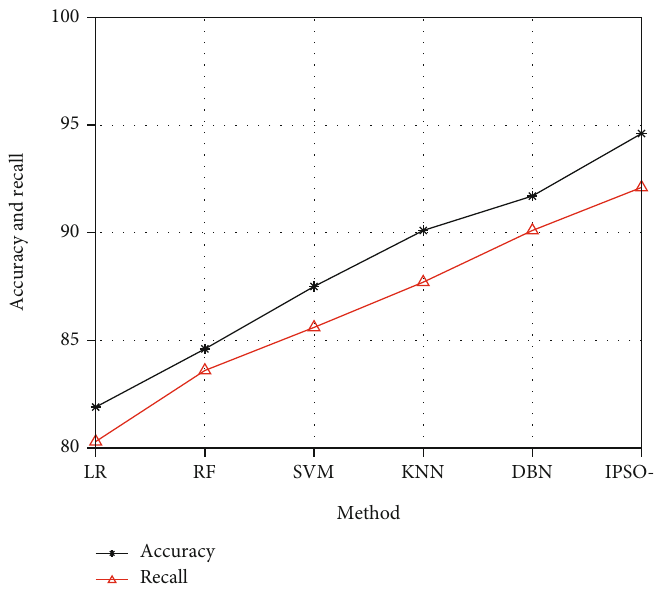
Figure 4: Method